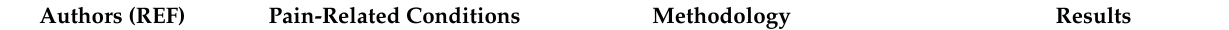
Table 1. Summary of critical clinical evidence regarding specialized pro-resolving lipid mediators and pain-related conditions. Authors